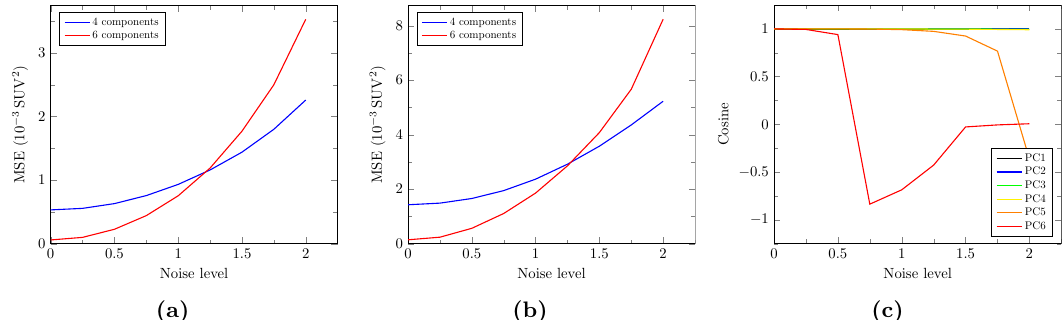
Figure 4. Influence of the noise level on the true signal reconstruction and on the definition of the first 6 principal components for the synthetic dataset. Mean squared error (MSE) between the true and estimated unnoisy TACs reconstructed from 4 (blue curves) and 6 (red curves) components for different noise levels, computed on the whole synthetic evaluation TAC set ( a ) and on the tumor synthetic evaluation TACs only ( b ). ( c ): Cosines between each principal component computed for noise levels ranging from 0 to 2.0 with step 0.25 and the corresponding component computed for a noise level of zero. Examples of true, noisy, and PCA-denoised evaluation TACs with 4 components are depicted in Figure 5. Reconstruction with only 4 components is remarkably accurate while